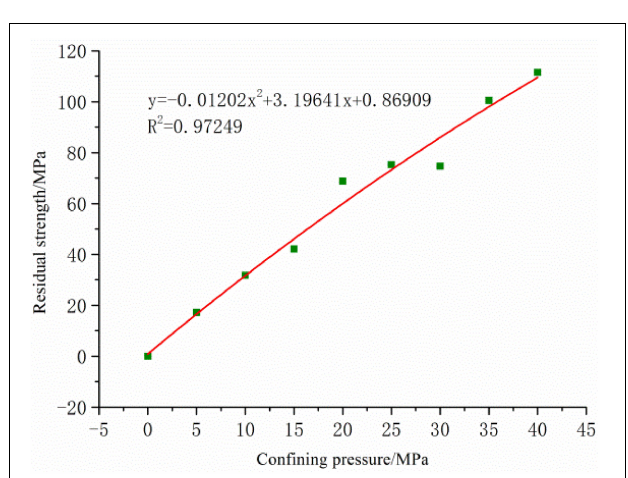
FIGURE 6 | Curve of residual strength vs. confining